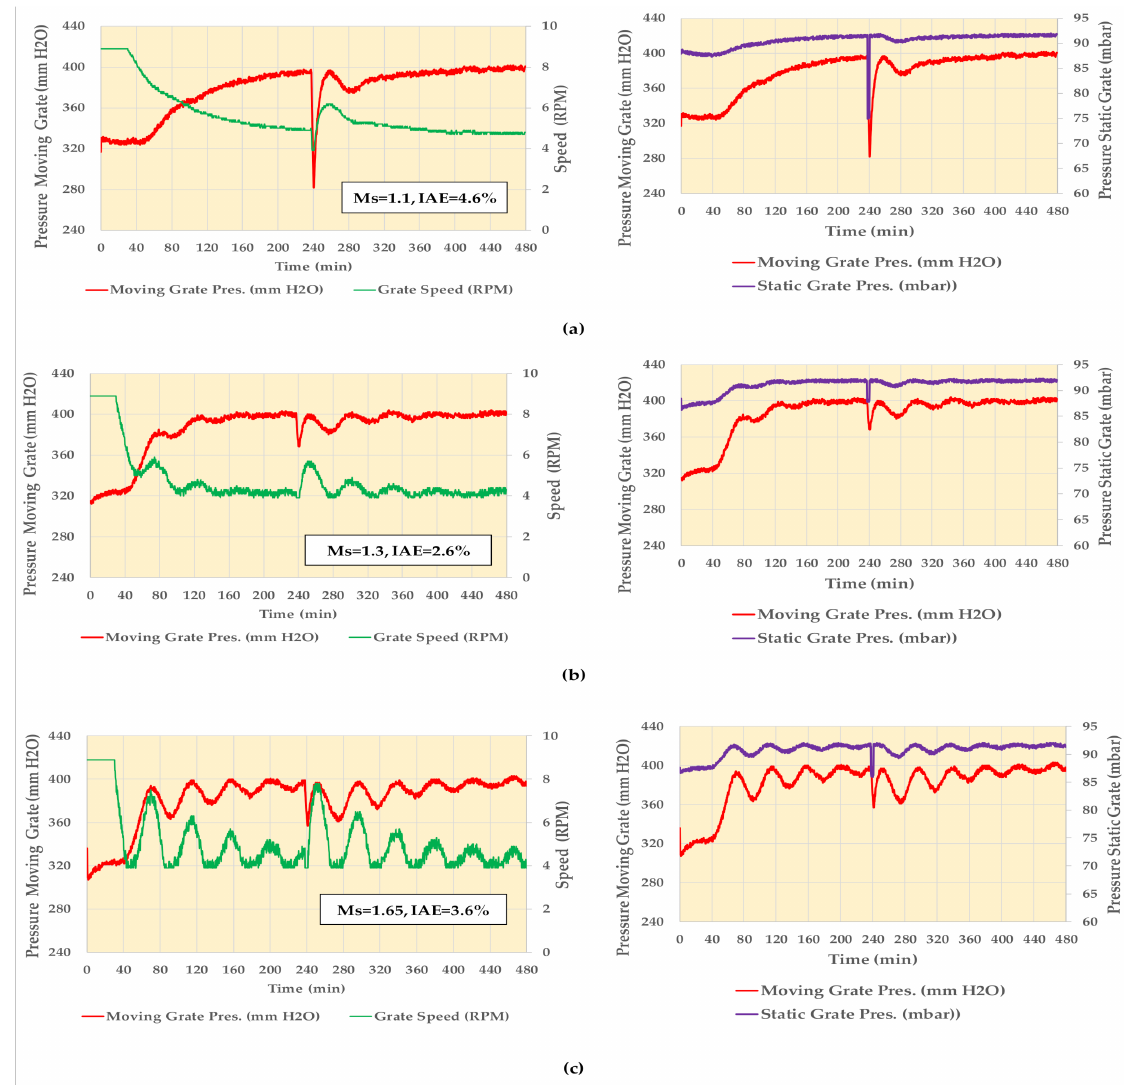
Figure 8. Function between pressure of moving grate, grate speed, and pressure of static grate for ( a ) M s = 1.1, k D = 0; ( b ) M s = 1.3, k D = 0.5; and ( c ) M s = 1.65, k D = 0.